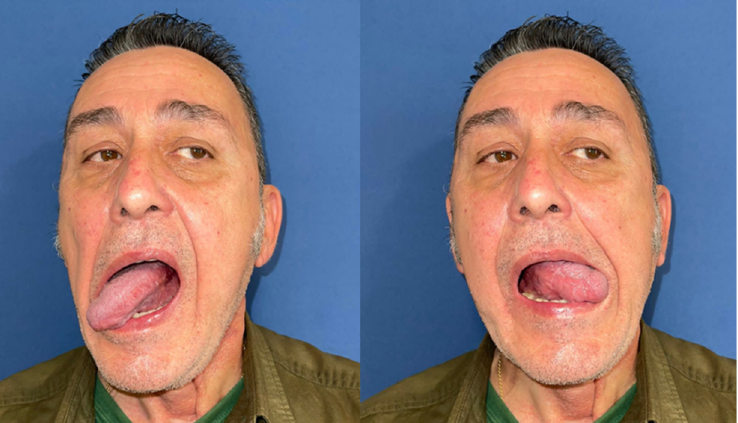
Figure 7. Excellent maximal lateral movement of the tip extending to the oral commissure on both sides.